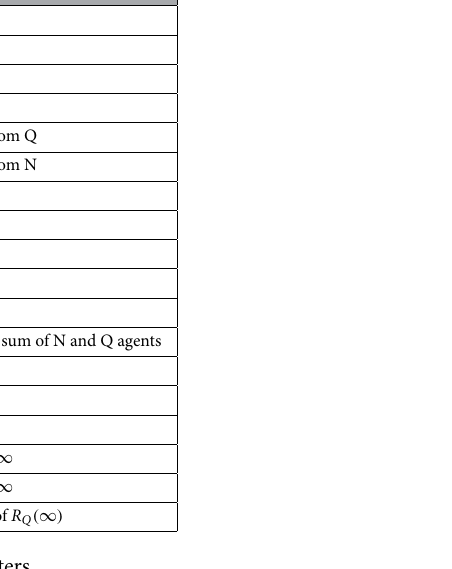
Table 1. Descriptions of symbols and